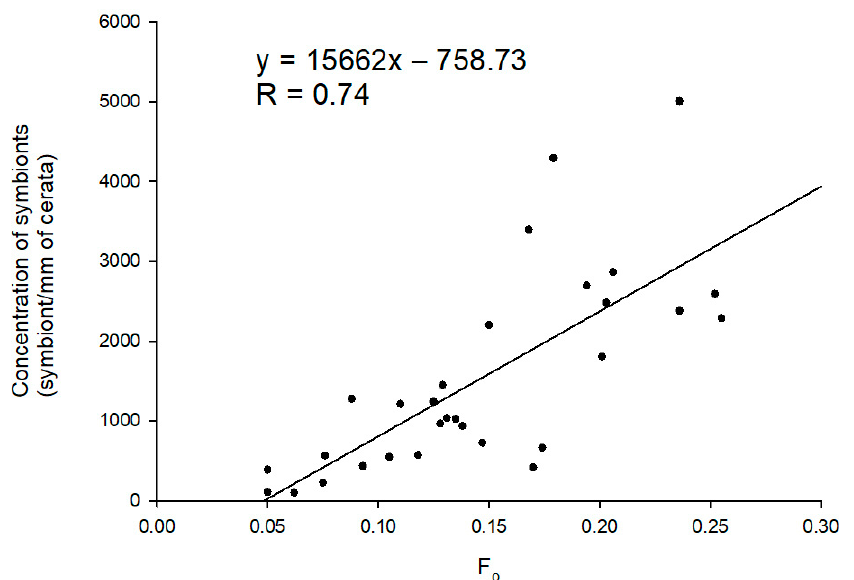
Figure 3. Correlation between the number of photosynthetic dinoflagellate endosymbionts within the cerata of Berghia stephanieae and fluorescence parameter F o (n = 30).